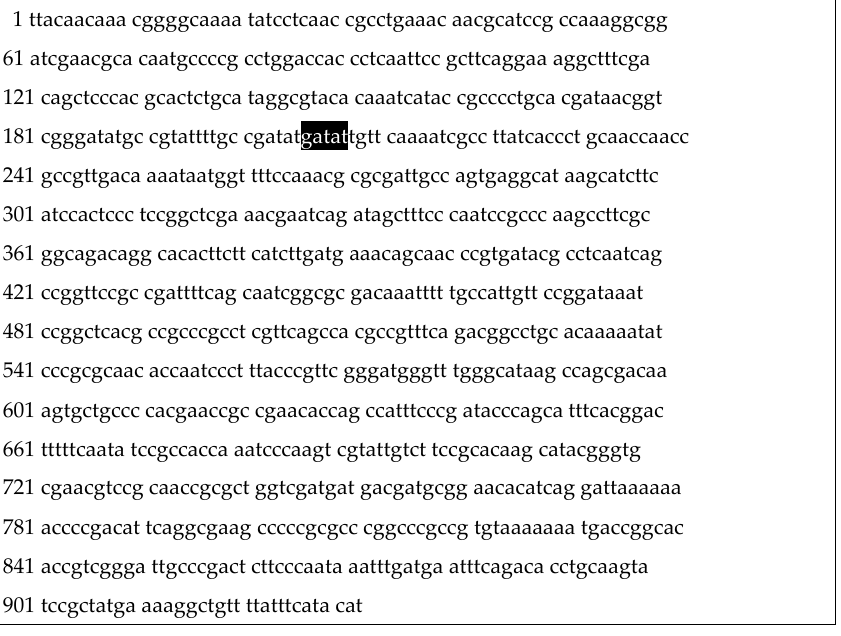
Figure 2. Localization of a 5 bp deletion at positions 733–737 in the pip gene of Russian atypical strains of N. gonorrhoeae ; the gene sequence is provided in reverse complementary form.